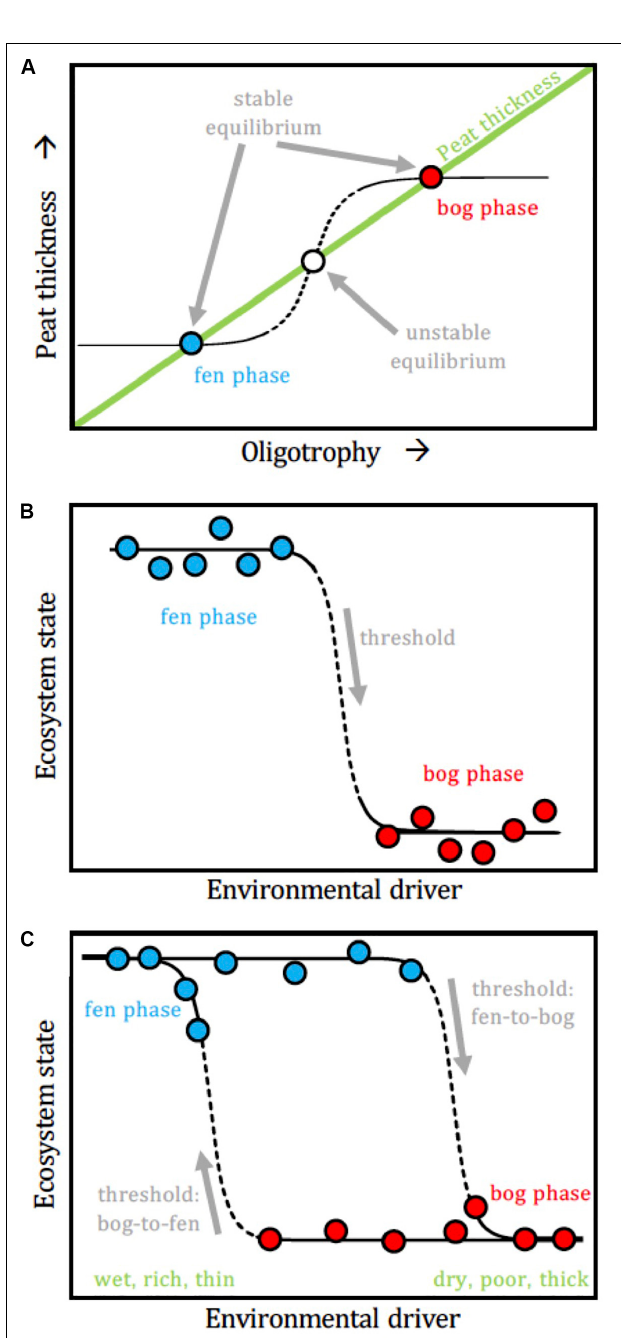
FIGURE 10 | Conceptual models for non-linear fen-bog transition scenarios. (A) Overall pattern, where the peatland state (fen vs. bog) responds non-linearly as oligotrophy increases along with peat thickness. There is no “intermediate” state between fen and bog but rather, once a threshold is passed, the system switches from one state to the other. (B) State-threshold model, where the regime shift in the ecosystem state takes place once a threshold in an internal driver (e.g., peat thickness) is exceeded. (C) Driver-state hysteresis, where a loop links the ecosystem state to the environmental driver, which results in jumps between two alternative stable